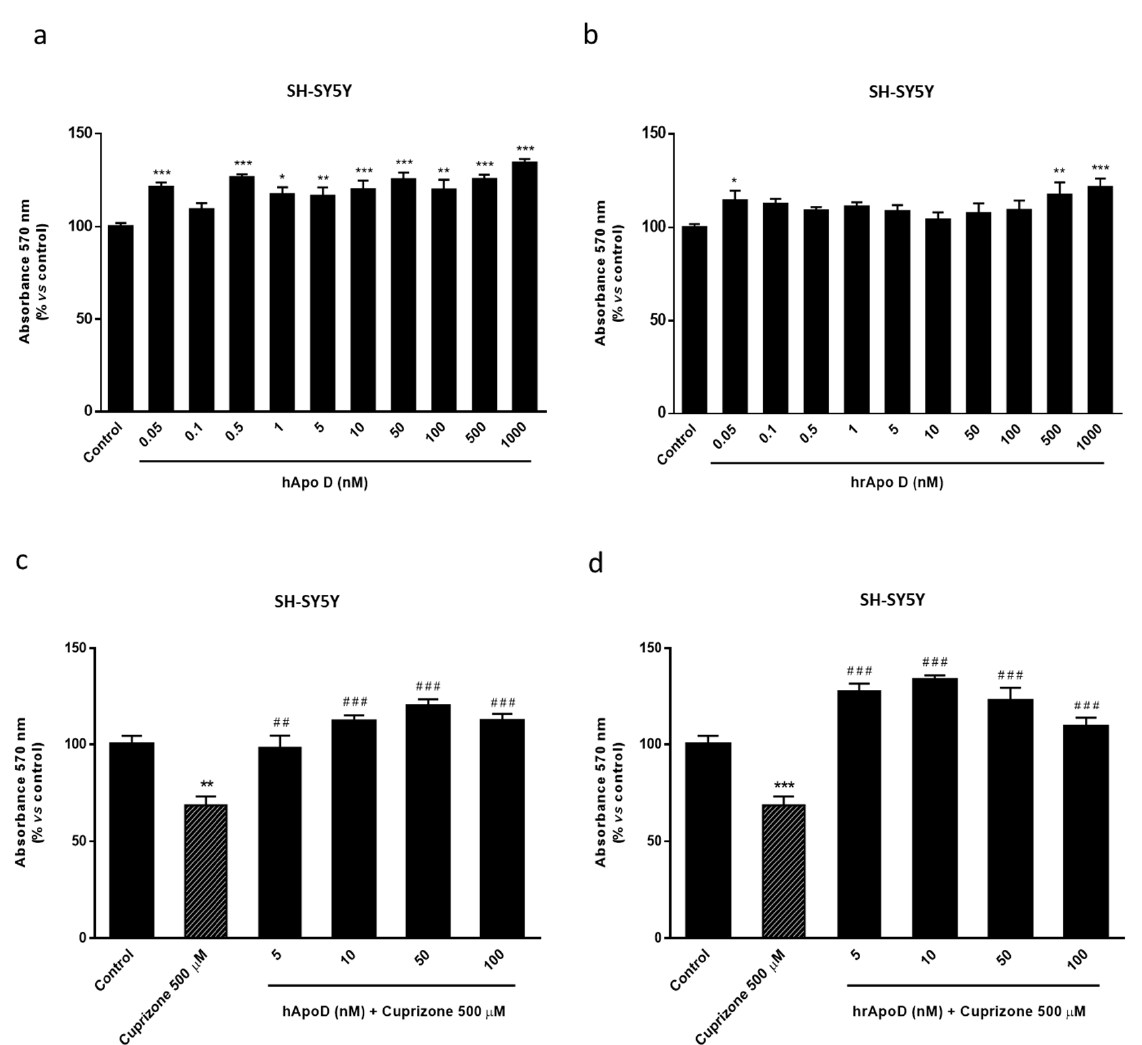
Figure 9. Top panel: MTT assays in SH-SY5Y cells treated with increasing concentrations (0.05–1000 nM) of hApo D ( a ) or of hrApo D ( b ) during 24 h. Bottom panel: MTT assays in SH-SY5Y cells treated with increasing concentrations (1–100 nM) of hApo D ( c ) or of hrApo D ( d ) for 24 h followed by 24 h with 500 µ M of CPZ. Cell damage is represented as the percentage of viability versus control. Data are the mean ± SEM of five independent experiments. Significant differences were analyzed by a one-way ANOVA followed by post-hoc Tukey’s test. * p < 0.05, ** p < 0.01, *** p < 0.001 compared with control; ## p < 0.01, ### p < 0.001 compared with CPZ treatment.